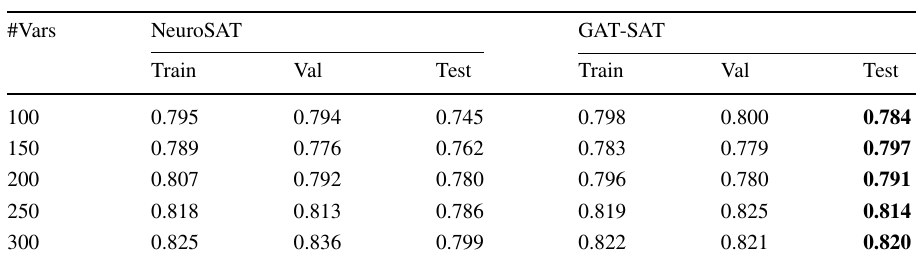
Bold values indicate the best